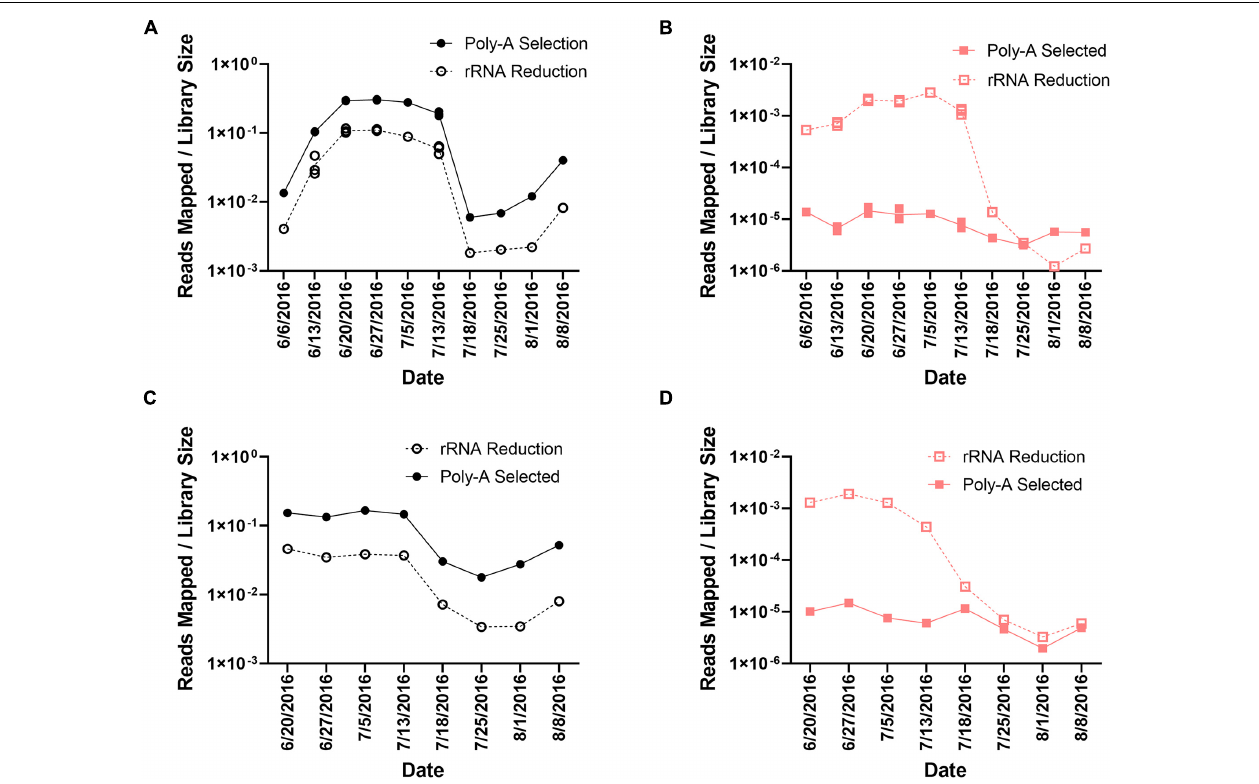
FIGURE 2 | Read mappings to A. anophagefferens and AaV. Library normalized reads mapping to (A) A. anophagefferens and (B) AaV in Quantuck Bay, and library normalized reads mapping to (C) A. anophagefferens and (D) AaV in Tiana Beach. On dates where multiple libraries exist, all individual values are